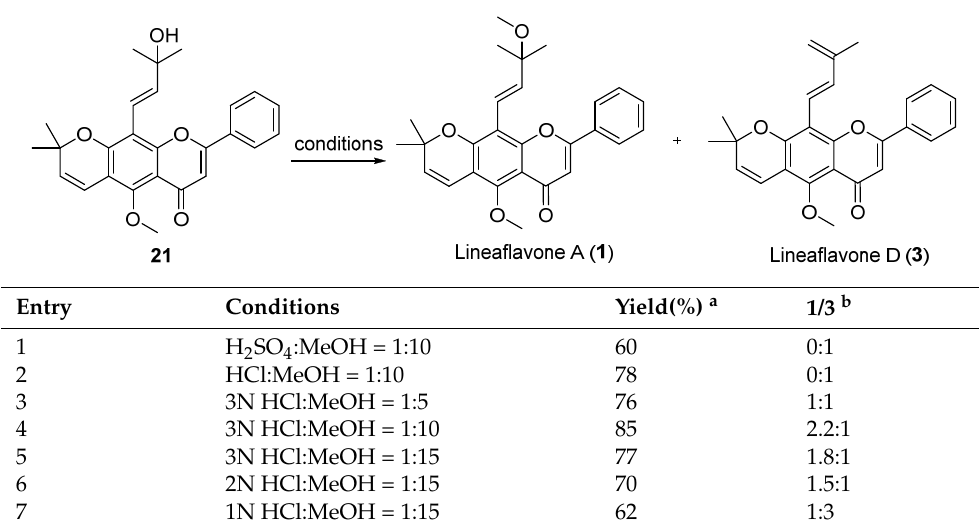
Table 1. Screening reaction conditions for the reaction.